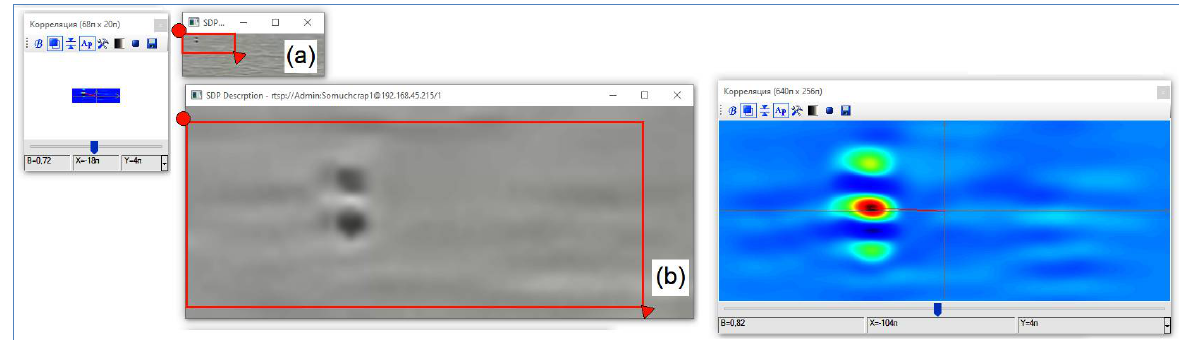
Figure 13. Recording of the buoy movements on two streams from the OMNY camera: ( a ) with optical zoom of 2.5 × , ( b ) when using additional 12-fold bicubic